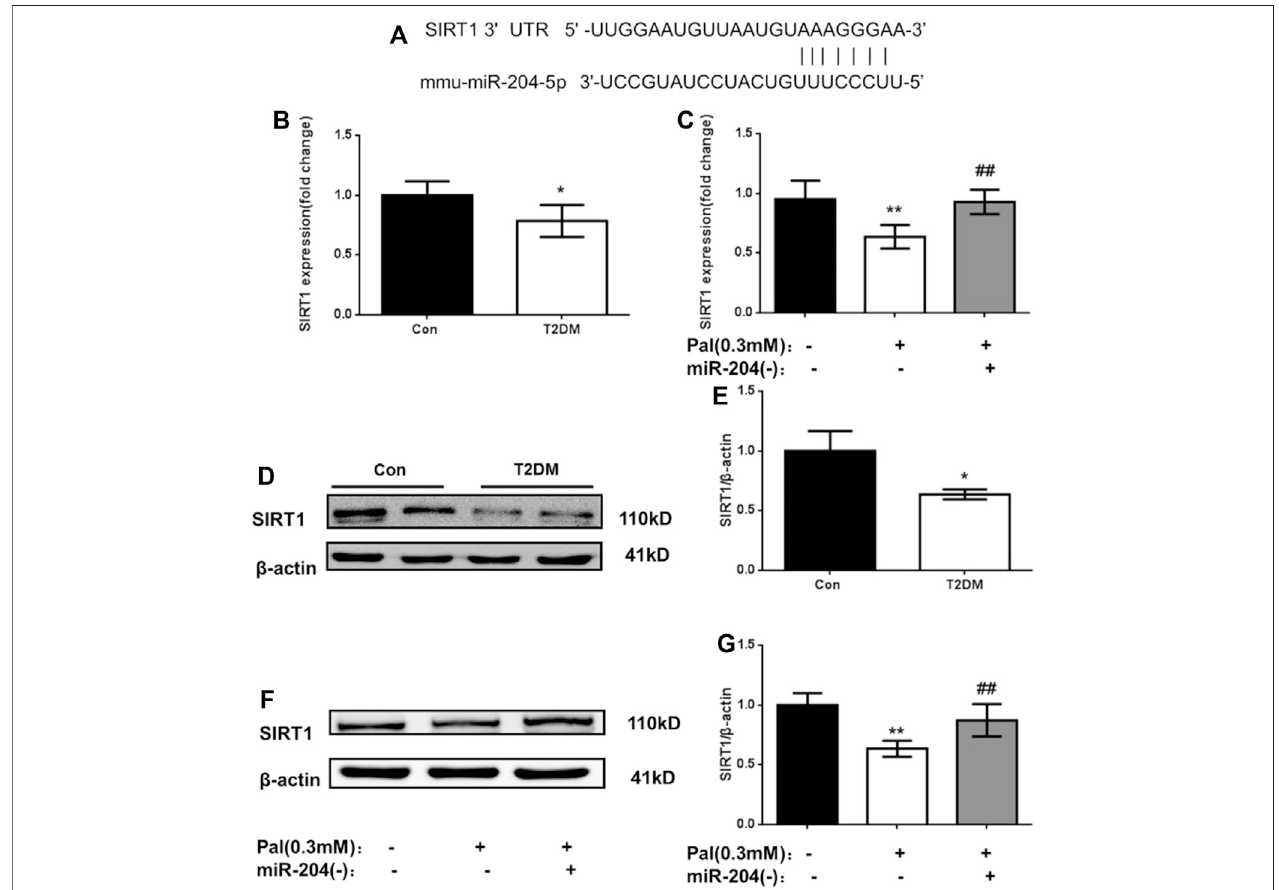
FIGURE3| ChangesofSIRT1level inisletsoftype2diabeticmodelsinvivoand invitro. (A) Thesequencesofmmu-miR-204and SIRT13 ′ UTRcomplementeach otherbythepredictionoftargetscan. (B) RNAwasexactedfromisletstissueandSIRT1wasmeasuredbyRT-PCRandanalyzed.Datawasexpressedasmeans ± SEM (n (cid:1) 3).* p < 0.05,comparedwithCONgroup. (C) AftertreatmentwithPAandmiR-204( − ),RNAwasexactedfromMIN6cellsandSIRT1wasmeasuredbyRT-PCRand analyzed.Datawasexpressed asmeans ± SEM( n (cid:1) 3). ** p < 0.01, compared with controlgroup; ## p < 0.01, compared withPAgroup (D,E) Proteinwasexacted from islets and SIRT1 was measured by Western blot and analyzed. Data was expressed as means ± SEM ( n (cid:1) 3). * p < 0.05, compared with CON group (F, G) The protein was extracted from cells and SIRT1 were measured and analyzed by Western Blot. Data was expressed as means ± SEM ( n (cid:1) 4). ** p < 0.01, compared with control group; ## p < 0.01, compared with PA